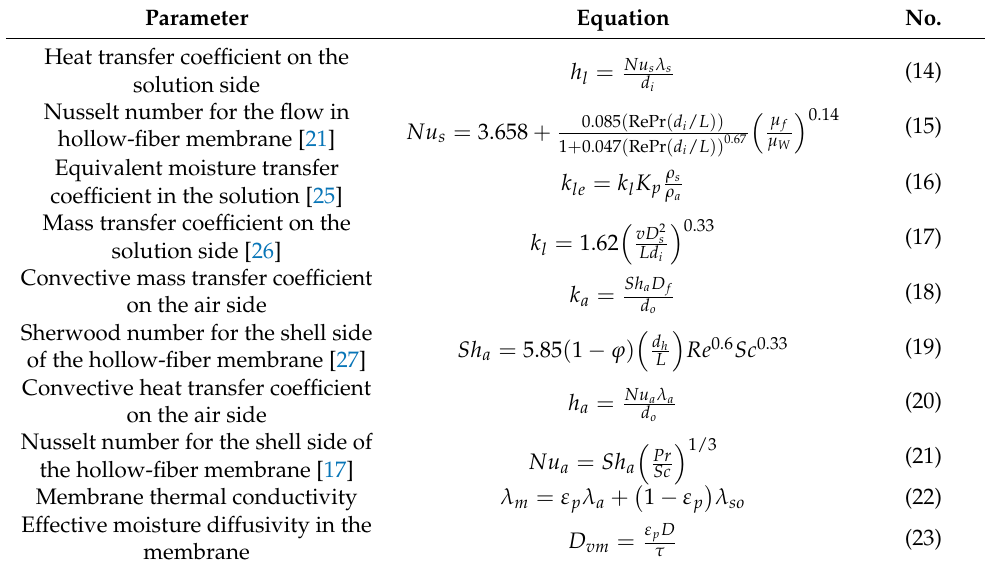
Table 4. Details of parameters for determining the individual